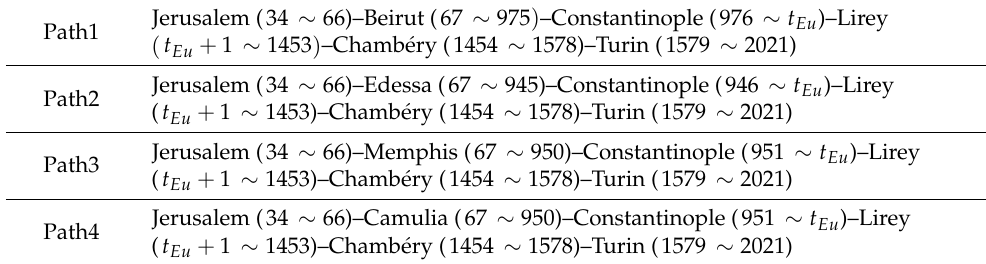
Table 1. Alleged historical–geographical paths of the Shroud and its sojourns (year).